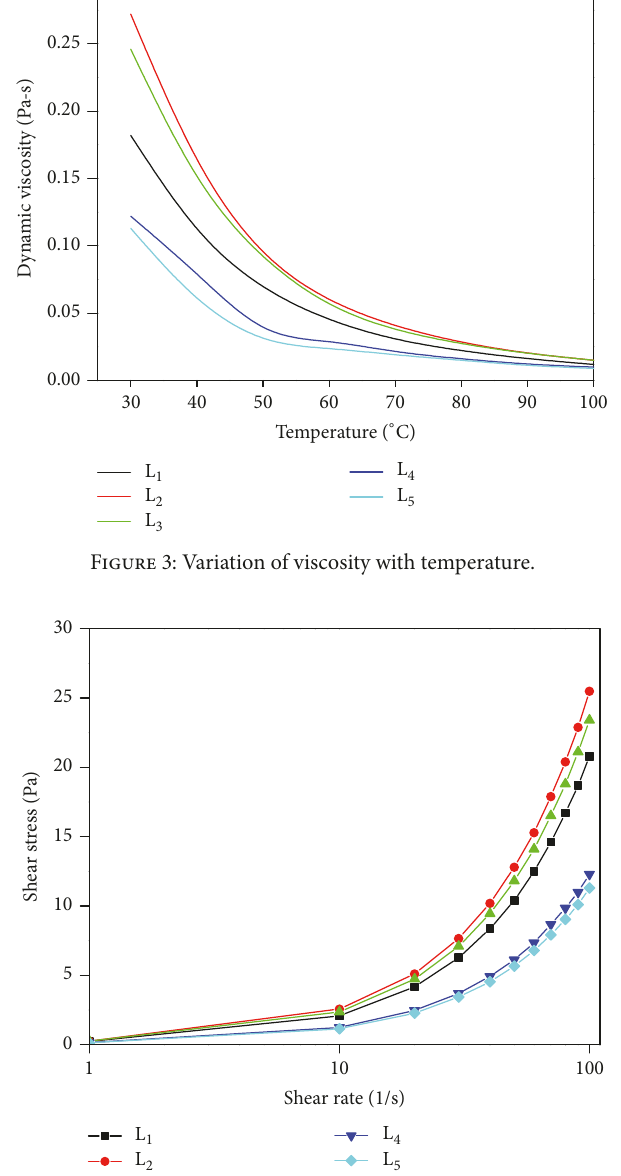
Table 5: Power law index of the lubricants.